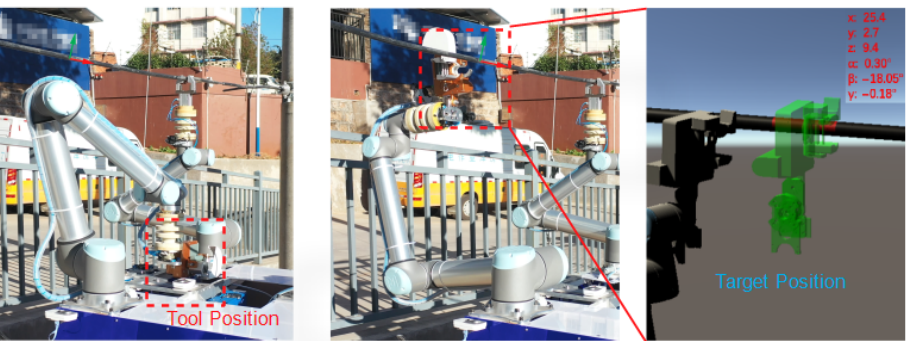
Figure 15. The beginning and end of motion planning.